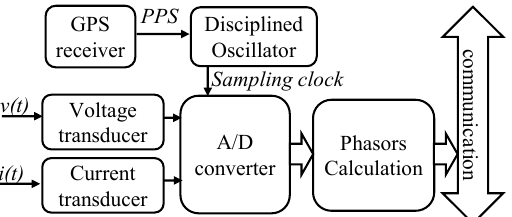
Figure 2. Basic architecture of a Phasor Measurement Unit, which typically include a GPS Disciplined Oscillator.